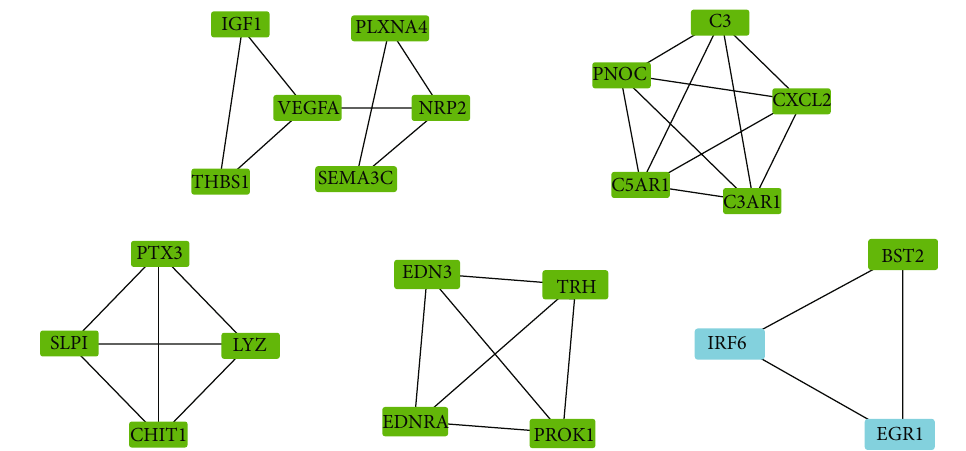
Figure 13: Modules 1-5 from the PPI network of TFs-IRGs. Table 2: Module analysis of the protein-protein interaction network.